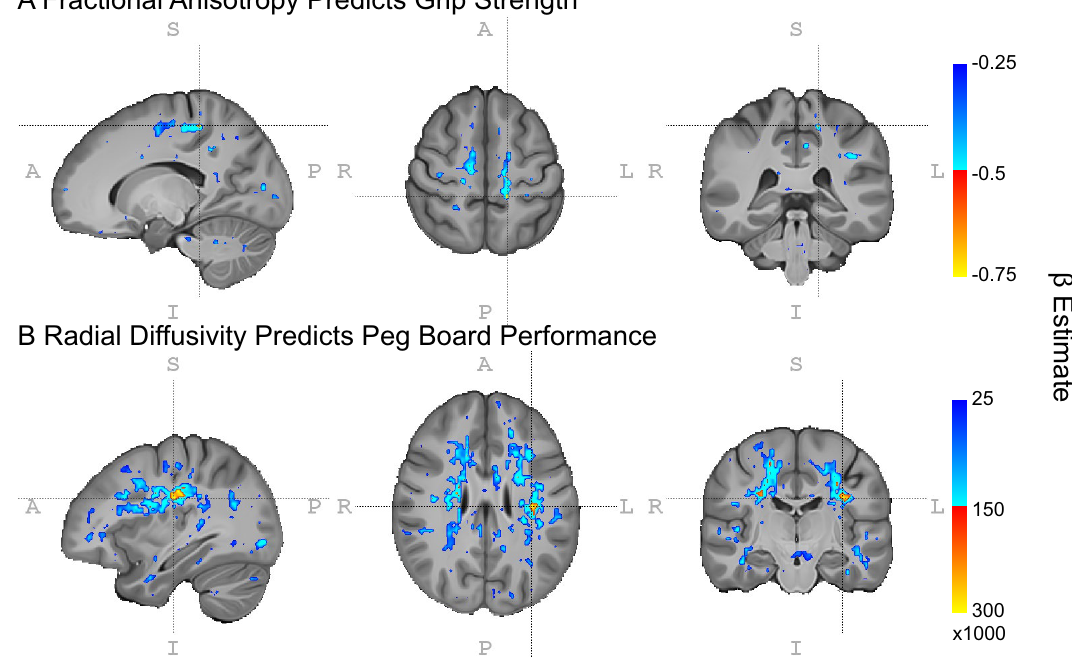
Figure 5. WM microstructure predicts motor outcomes. Fractional anisotropy predicts grip strength independently of disease duration and genetic burden. Voxelwise LME models suggest this relationship may be localized to WM underlying motor cortex (panel A ). Radial diffusivity predicts performance on the peg board task, where voxelwise LME models suggest this relationship may be widespread throughout the brain (panel B ). Cold colors indicate beta estimates for the group comparison in LME models thresholded at p uncorrected < 0.05; hot colors indicate estimates thresholded at p uncorrected < 0.01. Neuroimages were created using ITK-SNAP (version 3.8.0, http://www.itksn ap.org/) 26 . Inkscape (version 0.1, https ://inksc ape.org/) was used to add labels and color bars to the